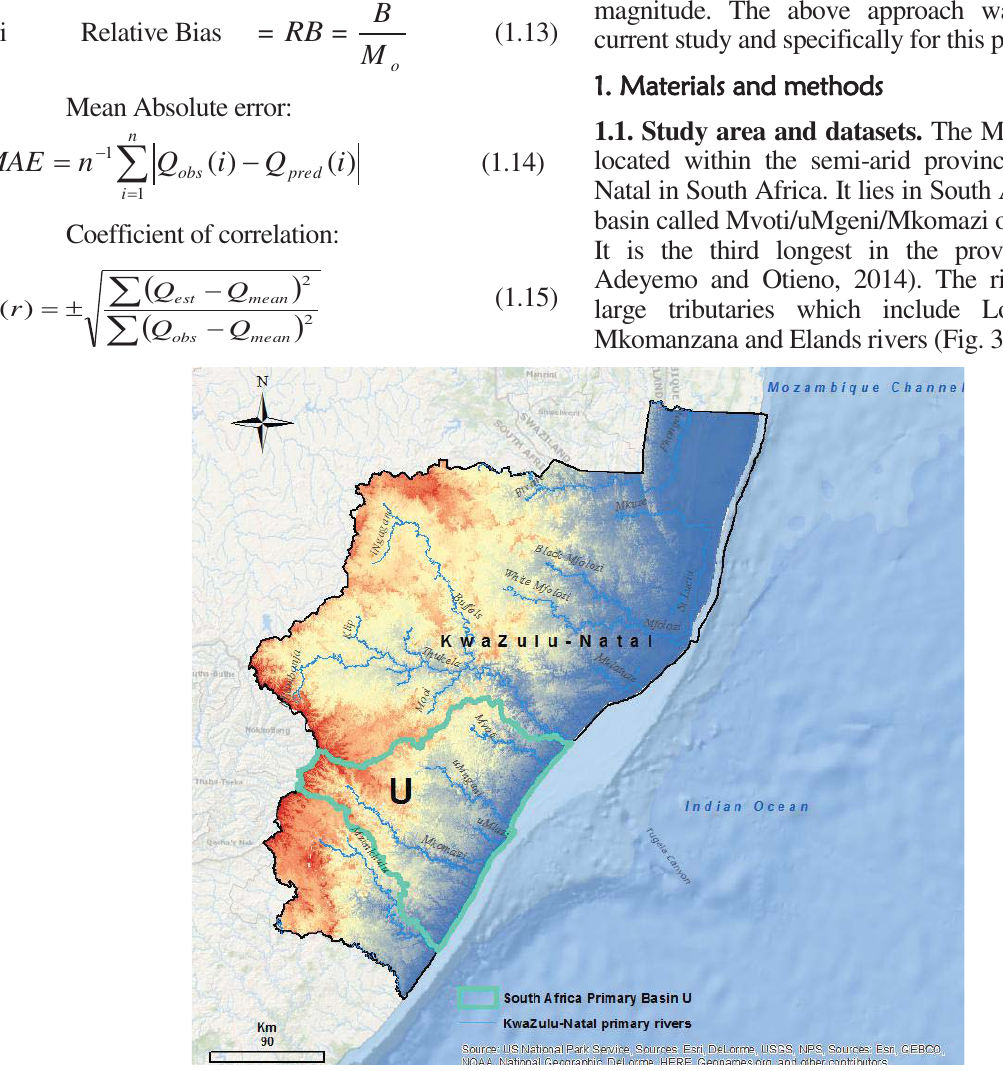
Fig. 2. Mvoti/uMngeni/Mkomazi primary basin (U) in KwaZulu-Natal